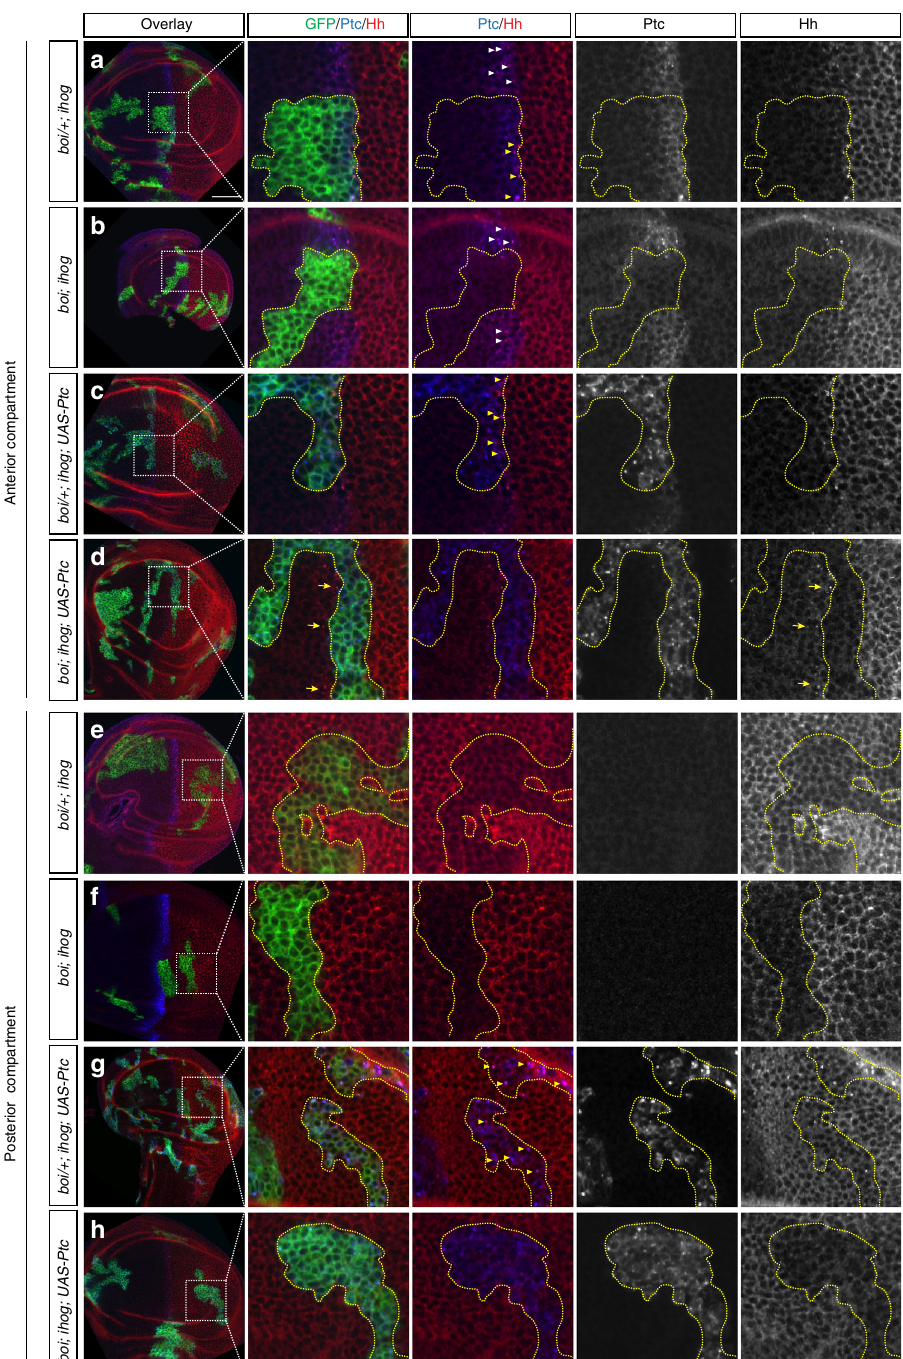
Fig. 2 Ihog/Boi is required for Ptc-mediated Hh endocytosis in vivo. a – h Wing discs were immunostained for GFP (green), Ptc (blue), and Hh (red). MARCM clones (indicated by expression of mCD8GFP) lacking ihog were induced in boi heterozygous ( boi /+; ihog in a , c , e , and g ) or boi hemizygous ( boi ; ihog in b , d , f , and h ) larvae. c , d , g , h MARCM clones simultaneously express a UAS-Ptc transgene. a – d In Hh-receiving cells of the A compartment adjacent to the boundary, Hh protein internalized with upregulated Ptc protein in wild-type cells ( a white arrow heads) or cells within clones with a single wild-type dose of boi ( a yellow arrow heads), but not in boi ; ihog double mutant clones ( b yellow outline). Ectopic expression of Ptc in boi ; ihog clones showed no rescue of Hh internalization ( d yellow outline). Note that HhN traveled through the UAS-Ptc -expressing boi ; ihog double mutant clones and accumulated in wild-type cells immediately anterior to the mutant clone ( d , yellow arrows). e – h In Hh-secreting cells of the P compartment, Hh protein internalized with ectopically expressed Ptc protein within clones with a single wild-type dose of boi ( g ), but not in boi ; ihog double mutant clones ( h ). Control ihog clones in boi heterozygous or boi hemizygous animals not expressing UAS-Ptc transgene showed no internalization of Hh ( e , f ). Scale bar, 50 µ